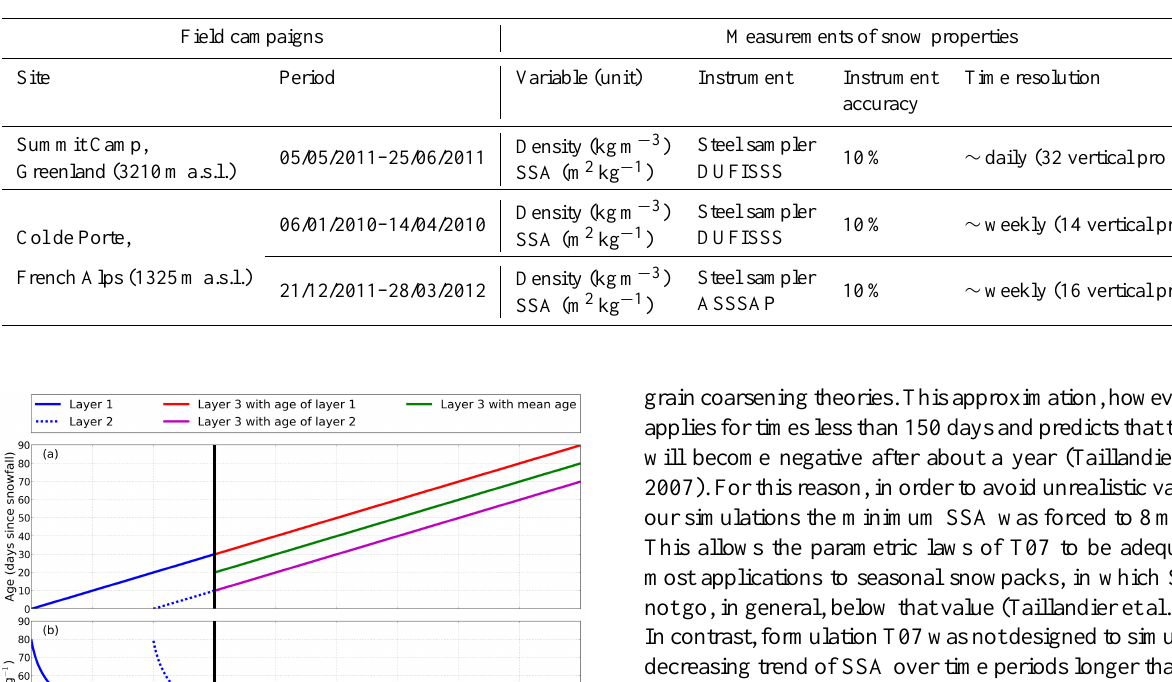
Table 3. Overview of the measurements acquired at Summit Camp in 2011 and at Col de Porte during the winters of 2009/2010 and 2011/2012. These data were used to evaluate the different representations of the snow optical diameter growth rate implemented in SURFEX/ISBA-Crocus.